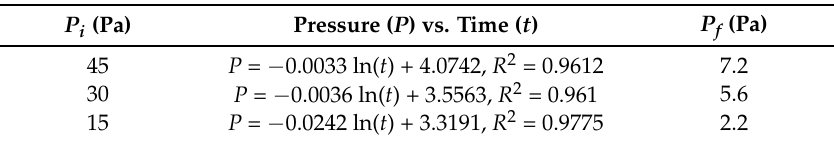
Table 2. Correlations of pressure ( P ) vs. time ( t ).